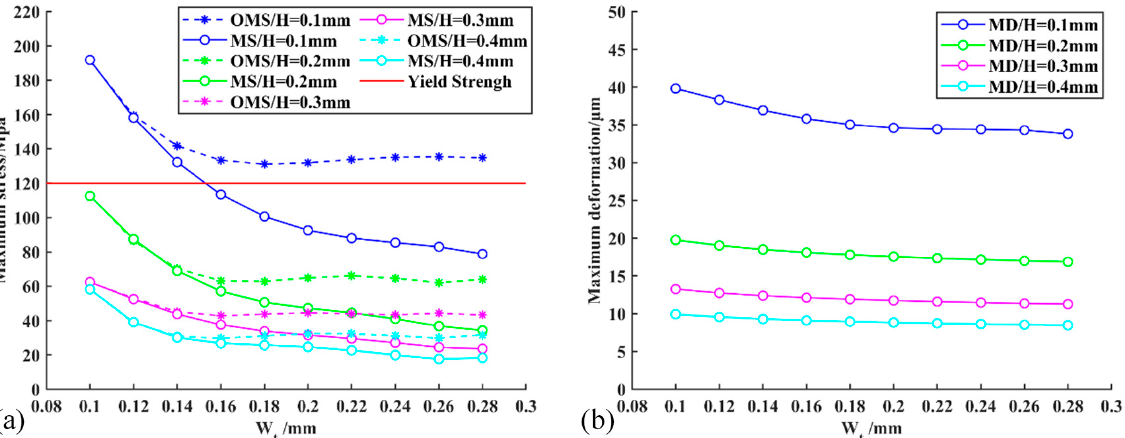
Figure 9. The relationship curves between maximum stress, maximum deformation and the geometric parameters H and W t of the micro-gripper’s tip are obtained by simulation, where H and W t have been shown in Figure 4c. ( a ) The relationship curves related to maximum stress, H and W t ; ( b ) The relationship curves related to maximum deformation, H and W t . Where MS = Maximum stress, OMS = Overall Maximum stress, MD = Maximum deformation.